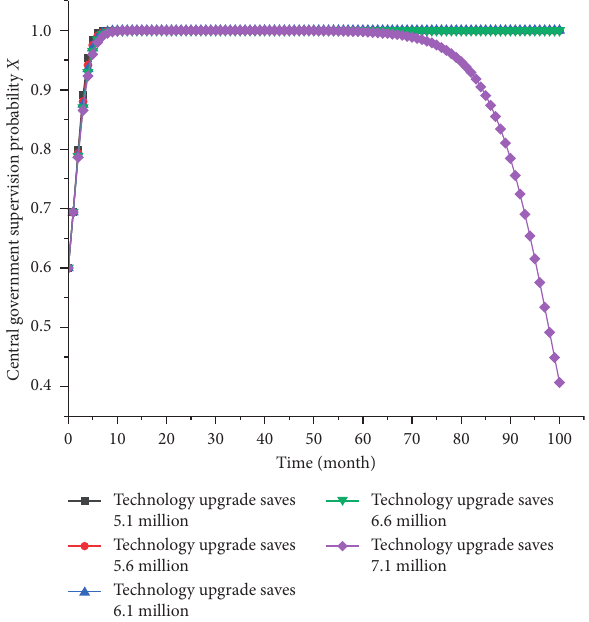
Figure 8: Impact of technology upgrade cost savings on local government strategy choices.